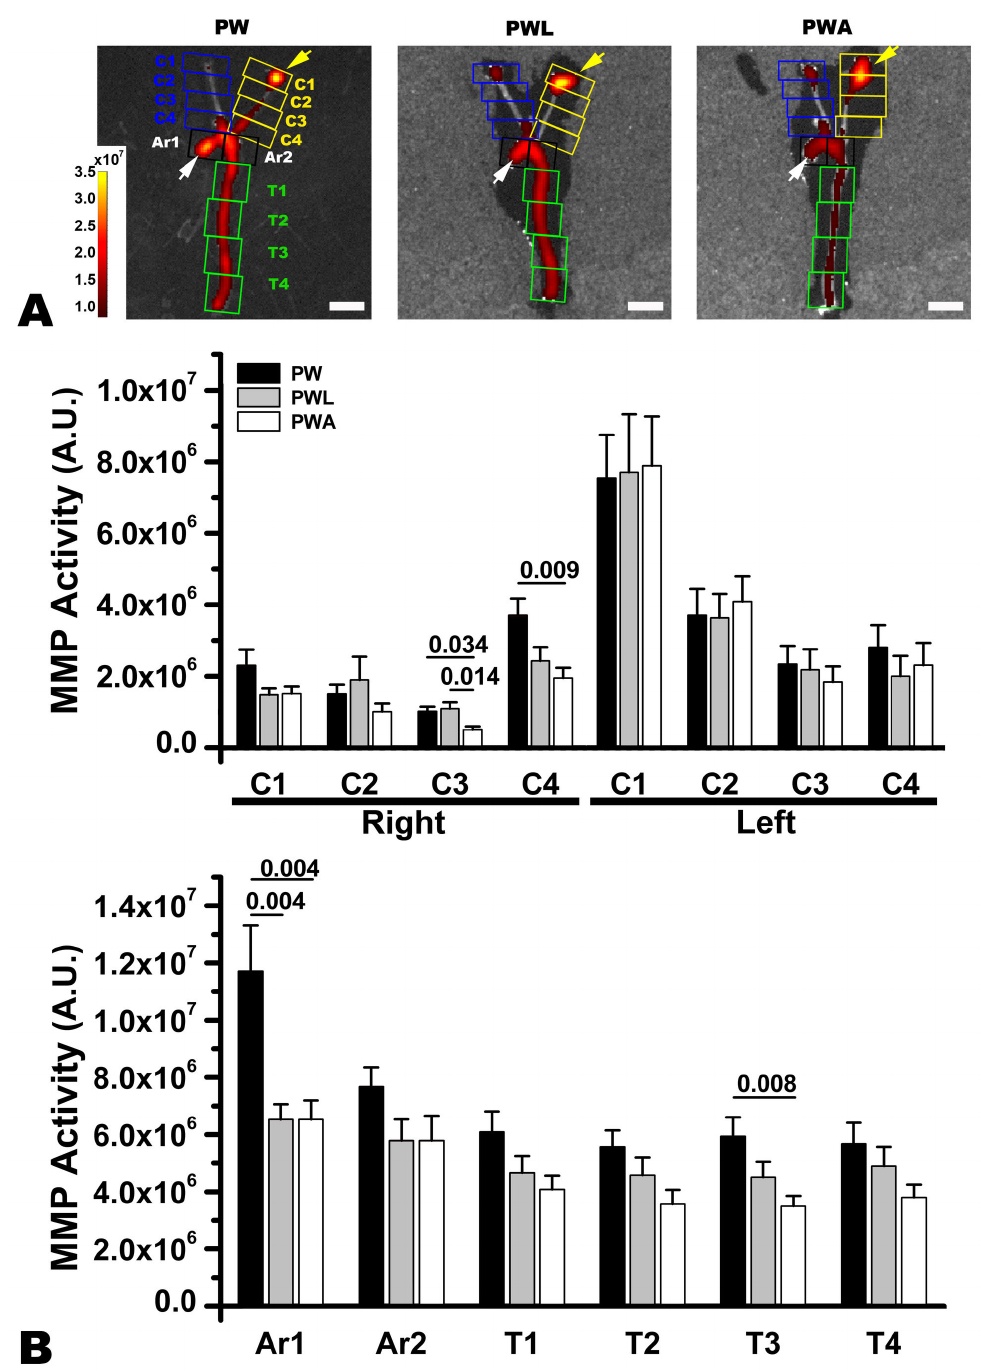
Figure 3. LiCl or atorvastatin treatment to attenuate matrix metalloproteinase (MMP)-2/9-related NIRF signal intensities in the aortic arch, but not in the ligated area of the common carotid artery (CCA). Two weeks after partial ligation of the left CCA, lower MMP-2/9-related NIRF signal intensities are observed in the proximal part of the aortic arch of the representative ApoE -/- mouse fed on a western diet with LiCl (PWL) or atorvastatin (PWA) than in that of the animal without treatment (PW) (white arrows); however, no inter-group differences are observed in the ligated area of the CCA (yellow arrows). Pseudo-color overlay with numbers (arbitrary unit) represents signal intensities (arbitrary unit). Quantitative data (B) corroborate the above findings. MMP activity was also attenuated in the proximal right CCA near the aortic arch (C3 and C4) and descending aorta (T3) of the western diet-fed mice treated with atorvastatin. Statistically significant p values from paired-t tests are provided. Scale-bar, 5 mm. doi: 10.1371/journal.pone.0073451.g003 PLOS ONE |